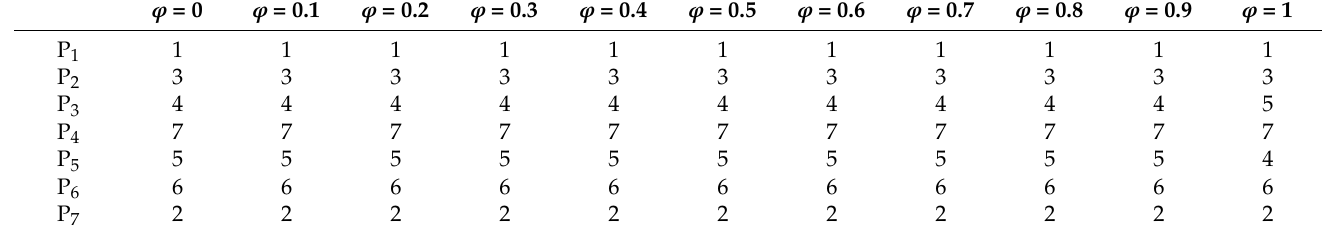
Table 12. The ranking of urban rail transit types under different ϕ values.